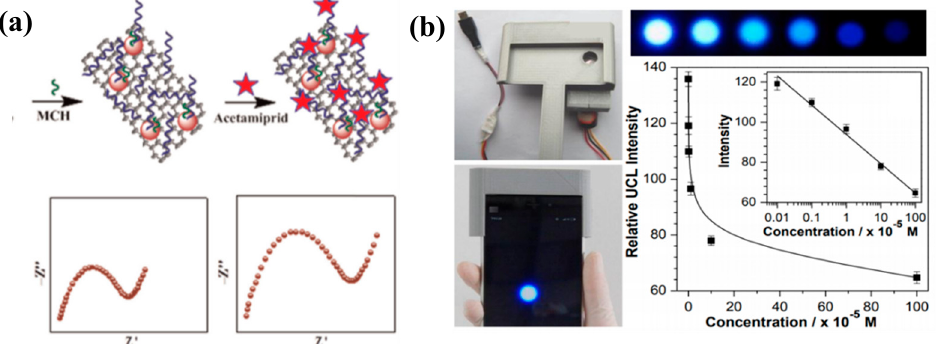
Figure 5. ( a ) Schematic representation of impedimetric aptasensor for detection of acedamiprid (reproduced with permission from [70]). ( b ) Image of smartphone − based detection setup and of luminescence test paper, and upconversion luminescence (UCL) spectra upon additions of different amounts of thiram (reproduced with permission from [71]).